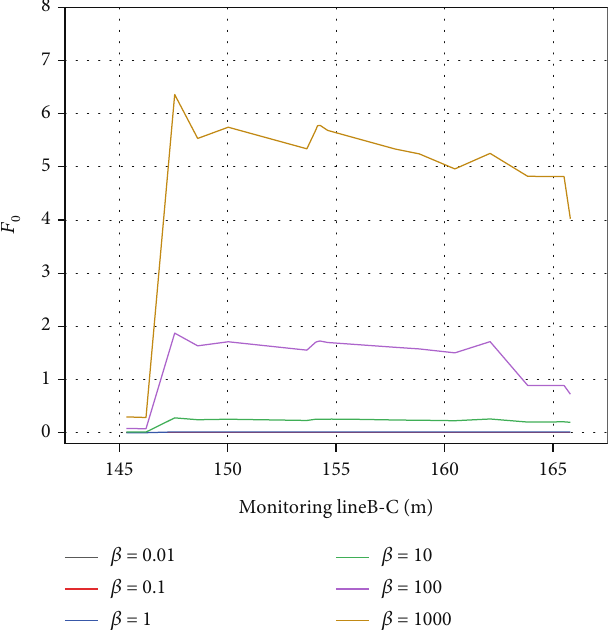
ff erent permeability